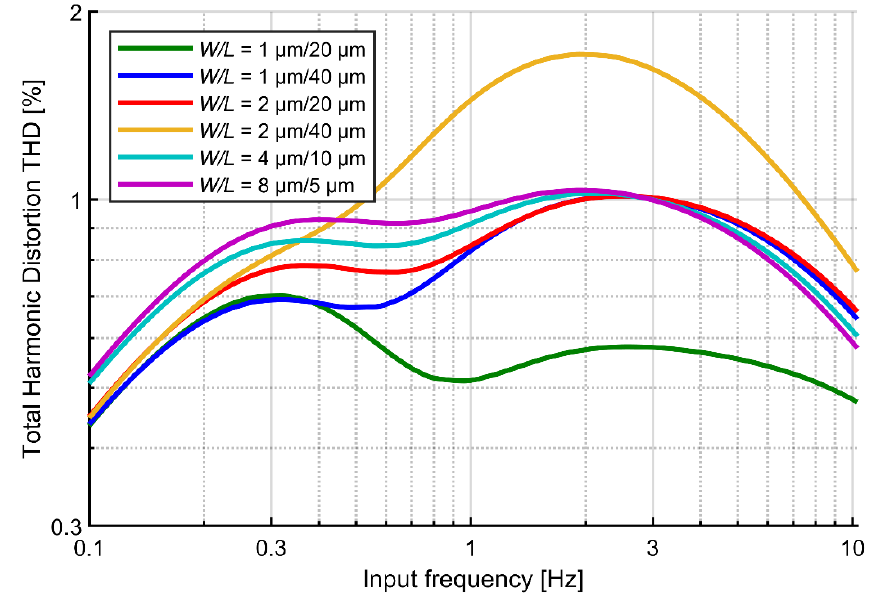
Figure 5. Simulated THD versus signal frequency for the fixed- V gs circuit for different dimensions of the pseudoresistor. Signal amplitude: 10 mV pp . V gs values were tuned for each simulation to get the same cutoff frequency (1 Hz).